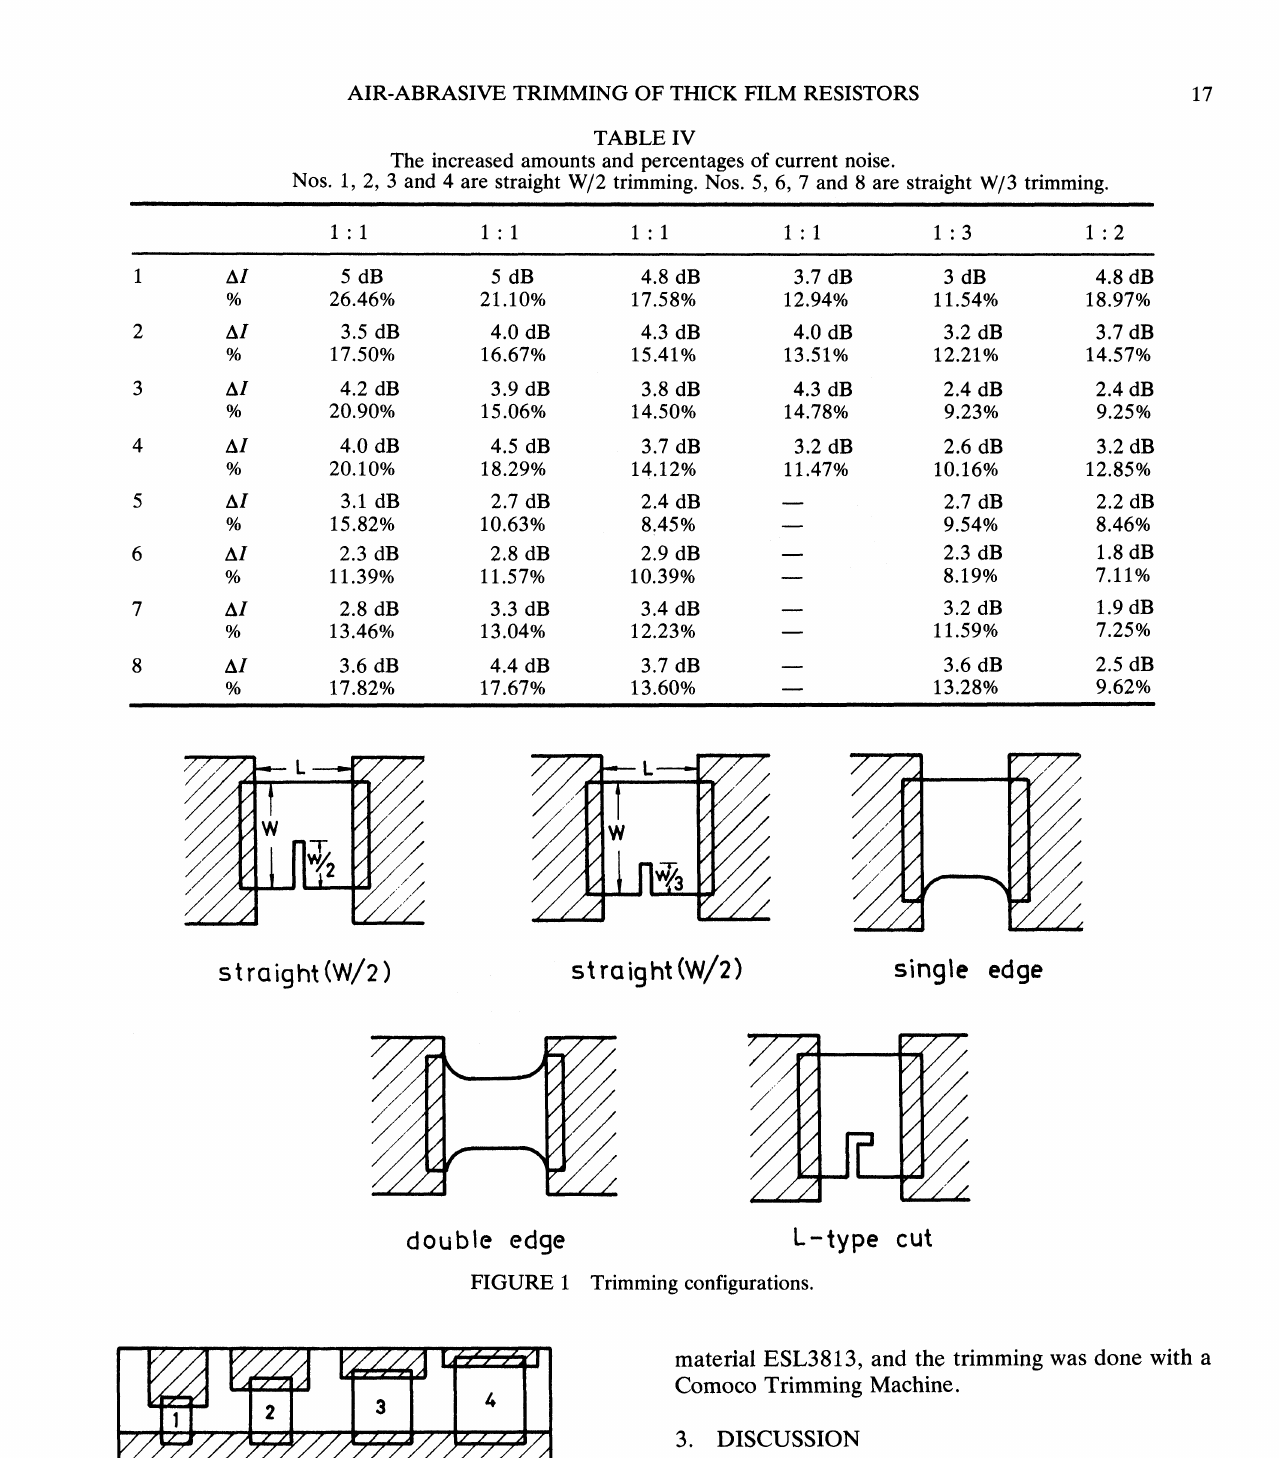
FIGURE 2 Test pattern.